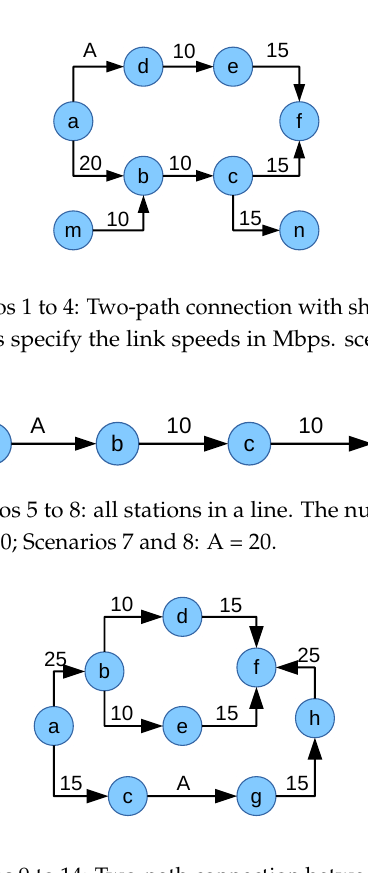
Figure 15. Topology of scenarios 9 to 14: Two-path connection between a and h where one of the paths is again split into two sub-paths. The numbers specify the link speeds in